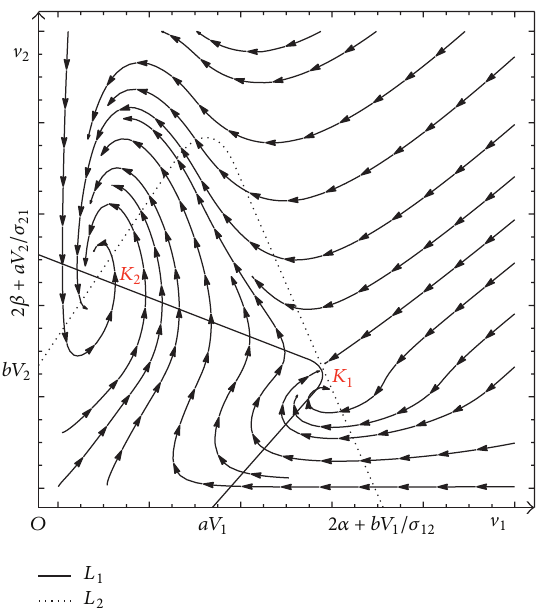
Figure 4: Two positive equilibria 𝐾 1 and 𝐾 2 . Condition 0 < 𝜎 12 < 𝜇 1 𝑉 1 (𝜆 2 − 𝜇 2 )/𝜇 2 (2𝛼𝜇 1 + 𝜆 1 𝑉 1 − 𝜇